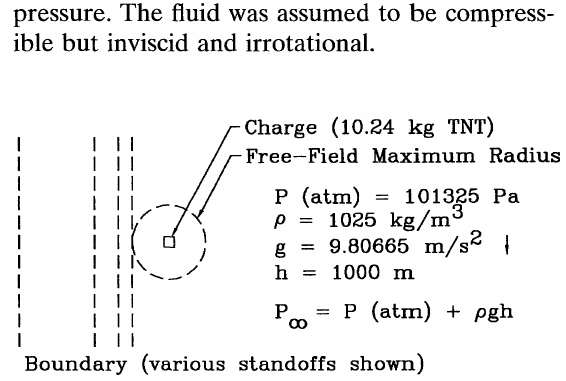
FIGURE 2 Problem geometry for the bubble near the boundary